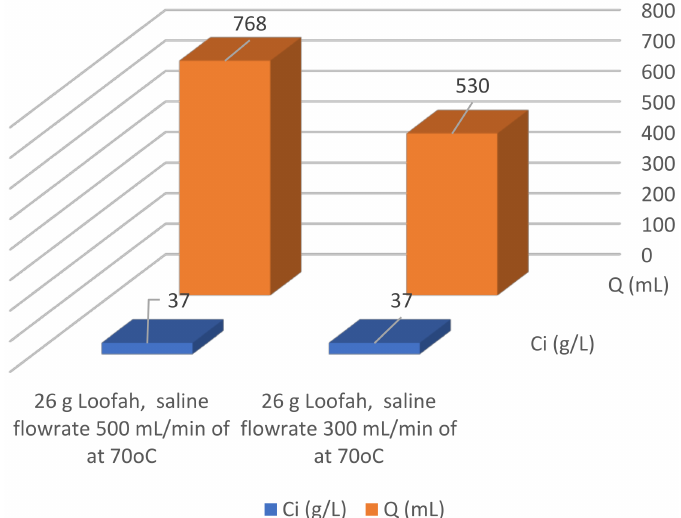
Figure 8. Effect of saline water flowrate.